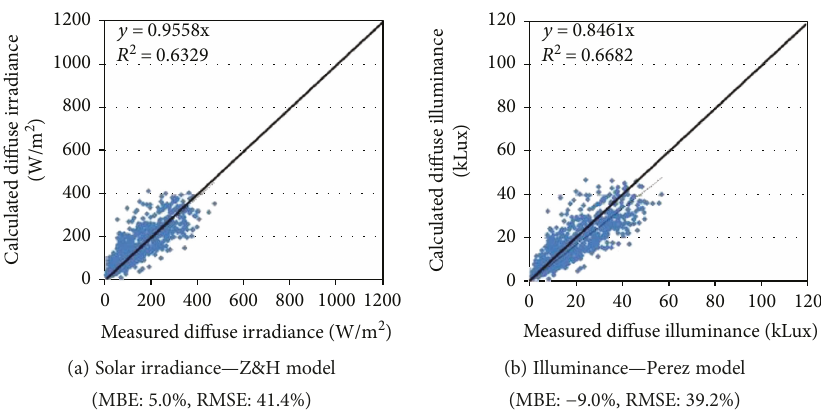
Figure 4: Scatter plotting of di ff use solar radiation and luminous e ffi cacy models performance for Manchester, UK